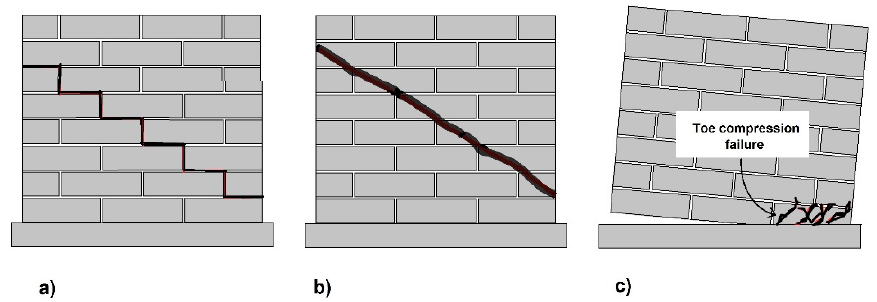
Figure 2. Modes of failure in masonry: ( a ) adherence failure, ( b ) diagonal traction failure, and ( c ) toe compression or foundation failure.